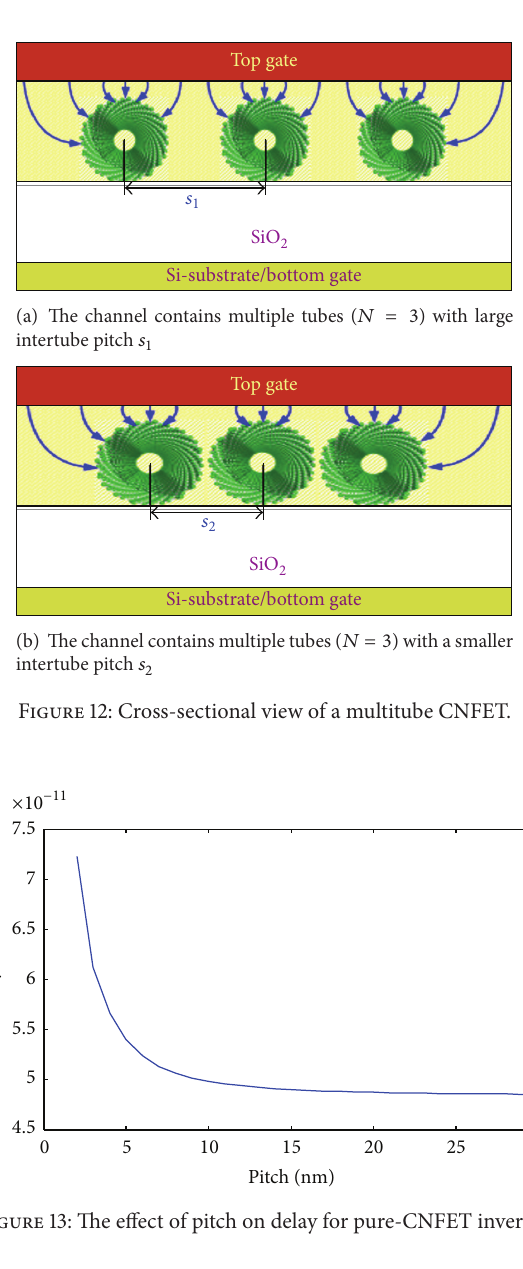
higher dielectric constant materials the increment in drain current with respect to 𝐾 ox reduces